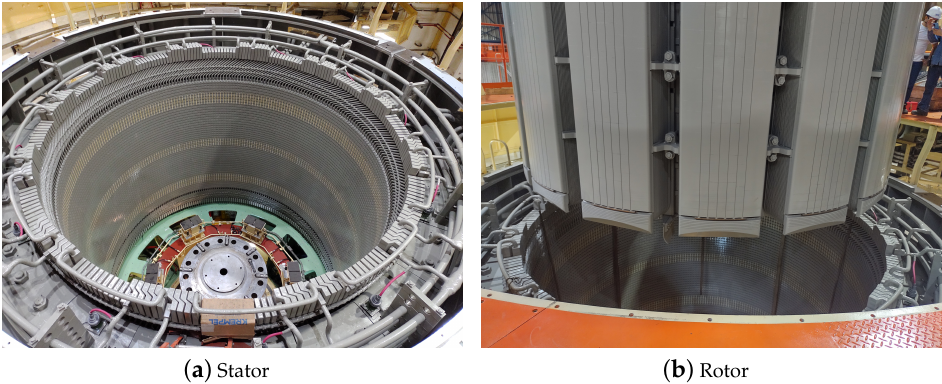
Figure 10. State of the rewinded Unit 5 stator and rotor. For reference, the rotor’s diameter is about 3